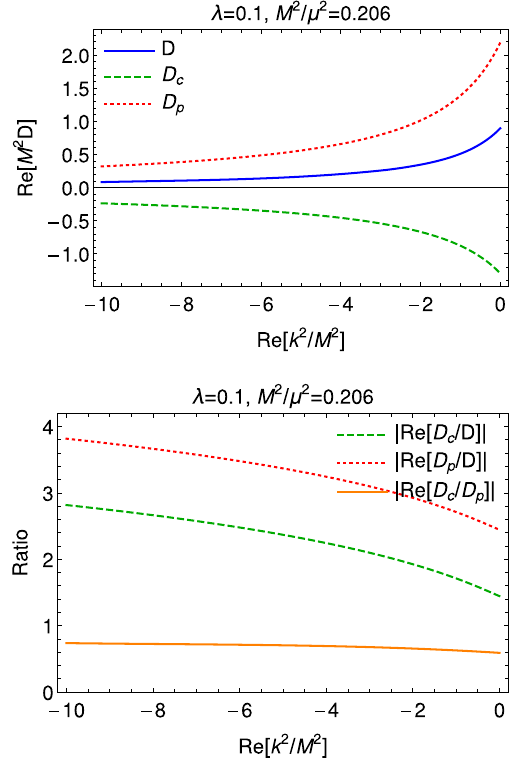
Fig. 22 The same plots for the gluon propagator in the Euclidean region as those in Fig. 18 for the choice of parameters with a smaller coupling constant, λ = 0 . 1, M 2 /μ 2 = 0 . 206